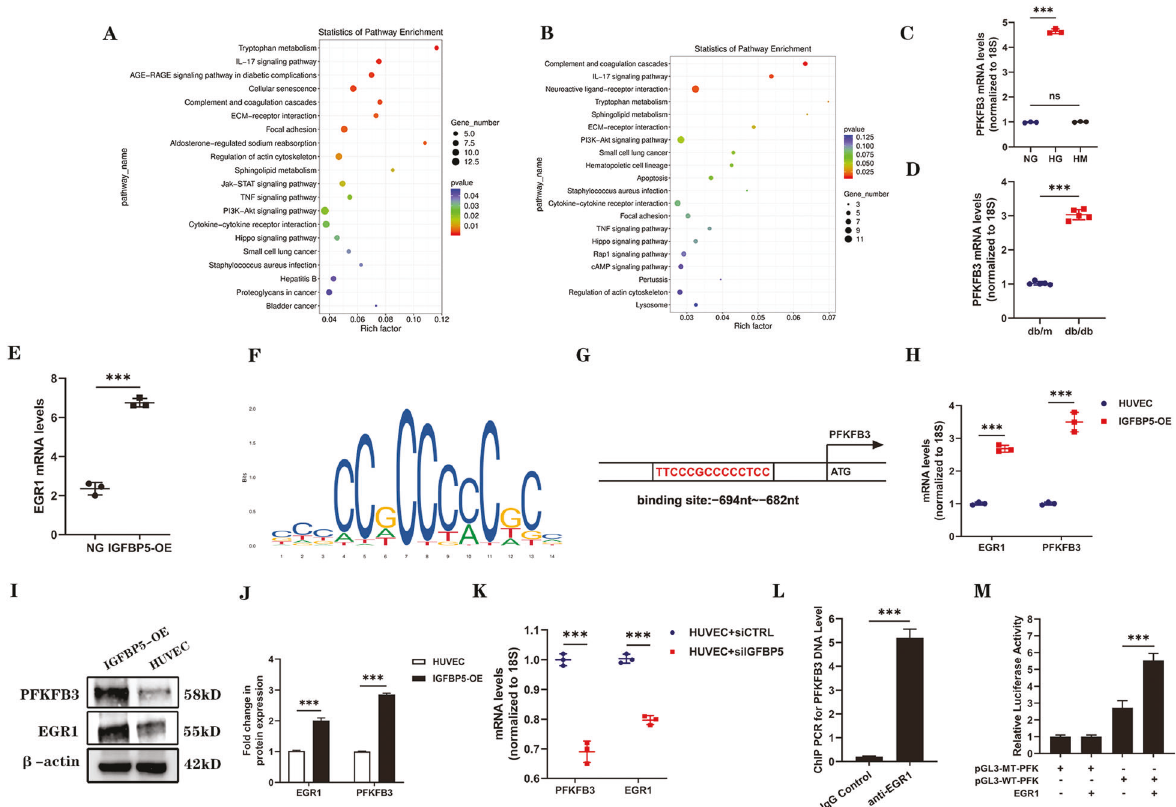
Fig. 3 IGFBP5 regulates the expression of PFKFB3 by regulating the binding EGR1 of to PFKFB3. RNA-seq analysis was performed on IGFBP5-OE- and HG-stimulated HUVECs. A KEGG pathway analysis of upregulated signaling pathways in IGFBP5-OE cells. B KEGG pathway analysis of upregulated signaling pathways in HG-stimulated HUVECs. C , D RT – PCR analysis of the mRNA levels of PFKFB3 in HG-treated HUVECs and the kidneys of db/db or db/m mice. n = 3. E RNA-sequencing data of EGR1 expression in IGFBP5-OE cells. n = 3. F The consensus EGR1-binding motif identi fi ed by WebLogo in the EGR1 ChIP-Seq data. G The target region of the PFKFB3 promoter to which EGR1 binds. H RT – PCR analysis of EGR1 and PFKFB3 mRNA levels in IGFBP5-OE cells. n = 3. I , J Western blot analysis and densitometric quanti fi cation of EGR1 and PFKFB3 protein levels in IGFBP5-OE cells under NG conditions. n = 3. K RT – PCR analysis of EGR1 and PFKFB3 mRNA levels in HUVECs transfected with siIGFBP5 under HG conditions. L ChIP-PCR results for PFKFB3. n = 3. M Dual-luciferase reporter assay results. n = 3. The data are shown as the mean ± SD. *** P < 0.001; ns, no signi fi